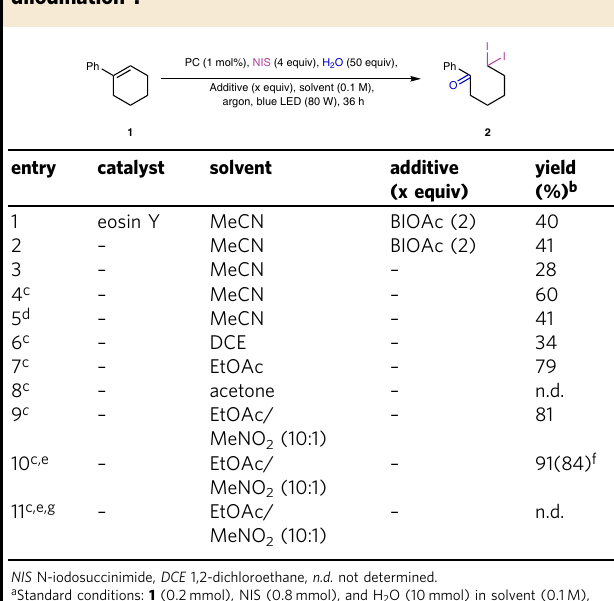
Table 1 Optimization of oxidative deconstructive geminal diiodination a